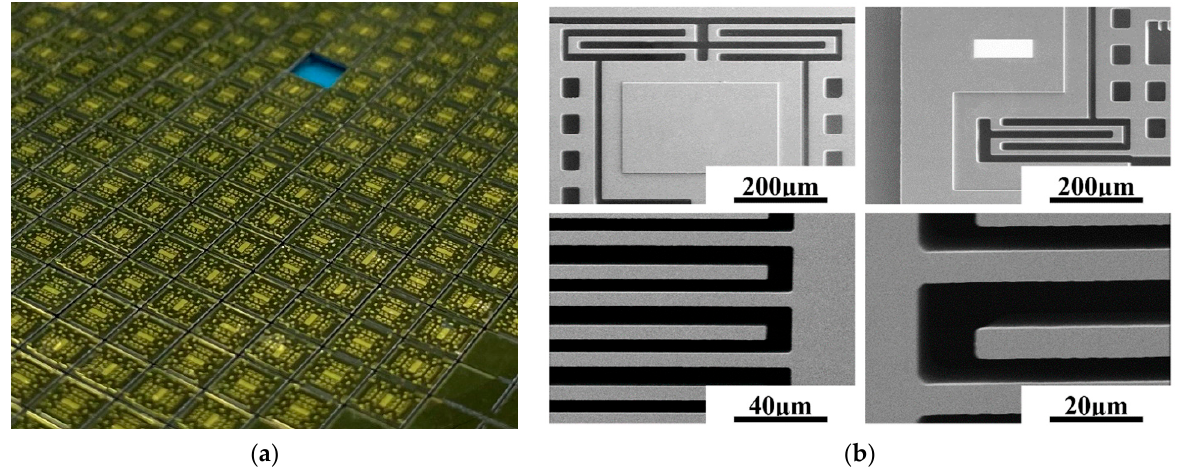
Figure 4. ( a ) A photograph of 3D wafer-level-packaged dual-mass TFGs; ( b ) SEM images for the MEMS structure.